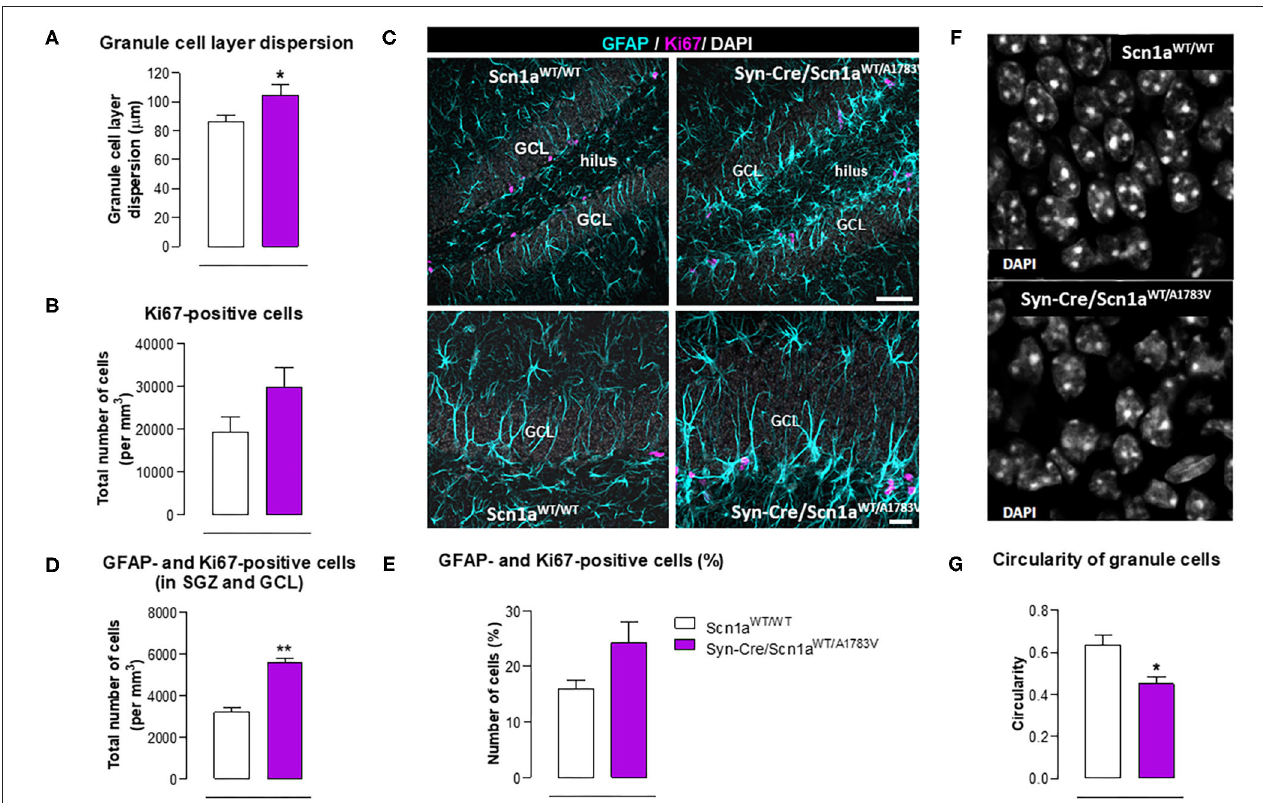
FIGURE 9 | Double immunofluorescence analysis of Ki67 and GFAP in the hippocampal dentate gyrus, including representative immunofluorescence images, of Syn-Cre/Scn1a WT / A1783V mice compared with Scn1a WT / W animals at PND25. Values are means ± SEM of six animals per group. Data were assessed by the Student’s t -test (* p < 0.05, ** p < 0.01 vs. the control group). Scale bar for double labeling = 50 µ m (top panels) and 20 µ m (bottom